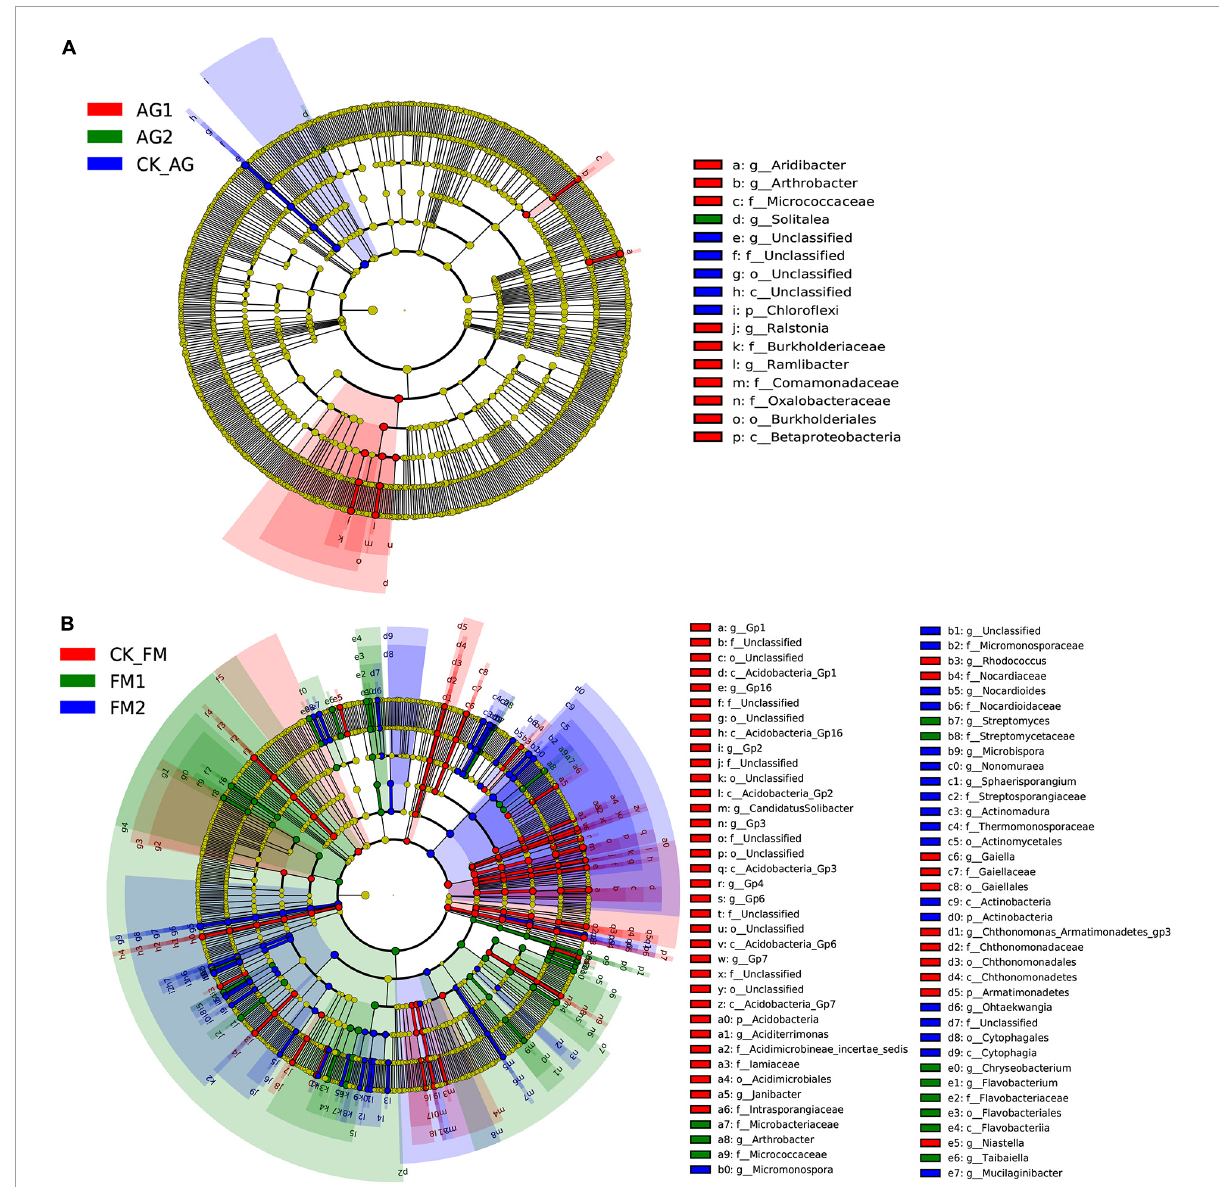
FIGURE5 LEfSe analysis showing different taxa among bacterial agent treatments (A) or fumigation treatments (B) . A taxon with the LDA value of larger than 3.2 was selected as different